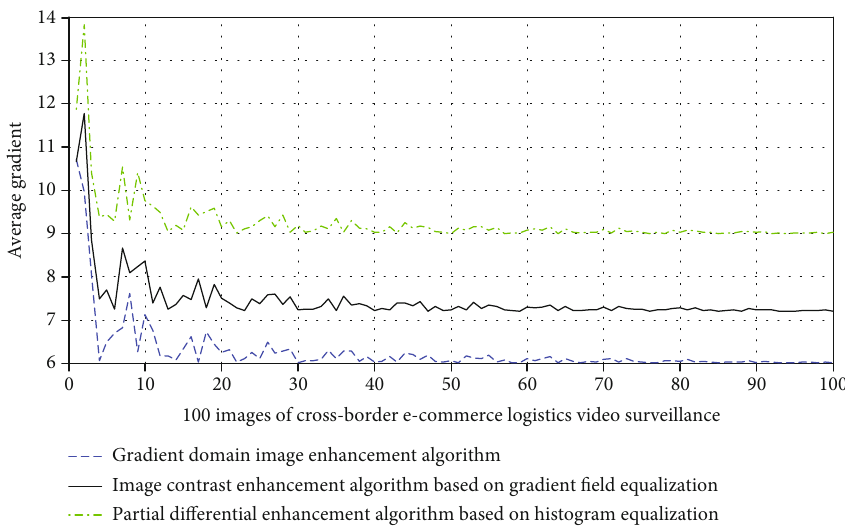
Figure 5: The average gradient of the experimental results corresponding to the three